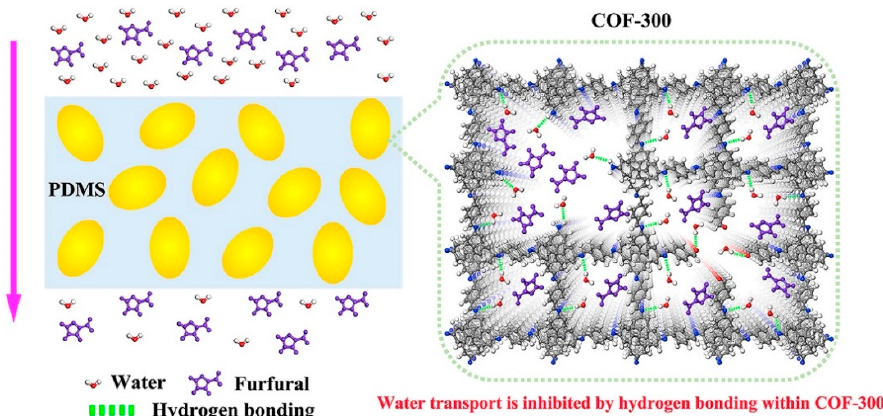
Figure 24. Schematic illustrating how COF-300 increases organic permeability while concurrently restricting water transport to improve pervaporation efficacy.